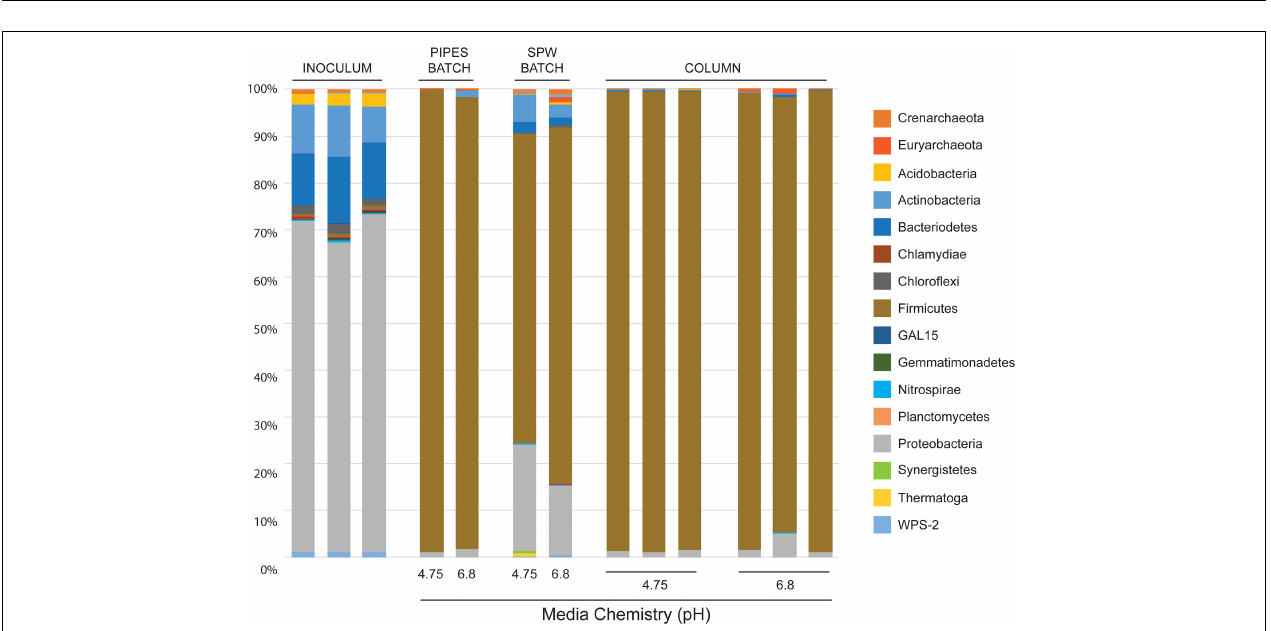
FIGURE 1 | Batch cultures of Fe(III) reduction in SPW canga. The concentration of dissolved Fe(II) (A) and total Fe(II) (B) were measured under static conditions over 3 months. Comparisons were made between sterile canga (open circles) or canga inoculated with sub muros material (closed circles), with a basal SPW medium pH of 4.75 (red) or pH 6.8 (blue). Error bars represent the standard deviation of triplicate incubations.